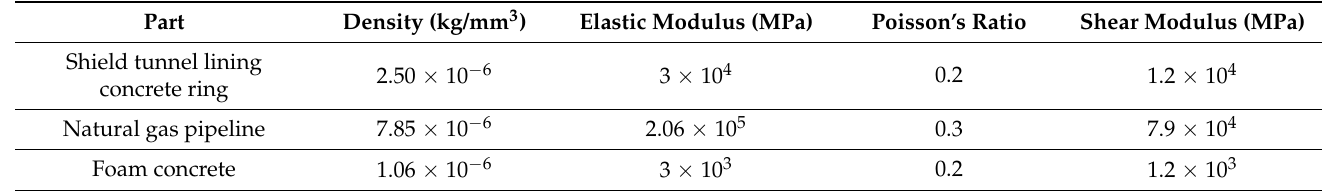
Table 9. Material parameters of shield tunnel for natural gas pipeline.